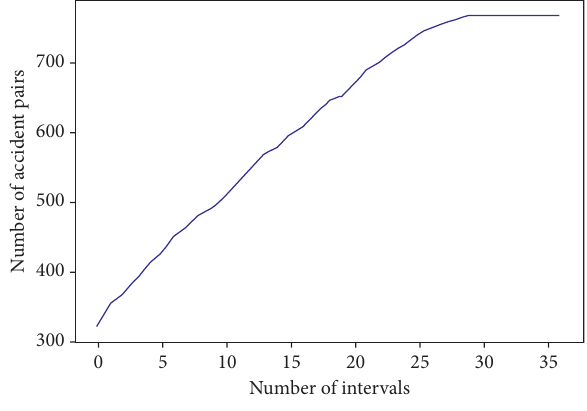
Figure 6: Sensitivity at 5-minute intervals. Table 2: Correspondence table of variable and